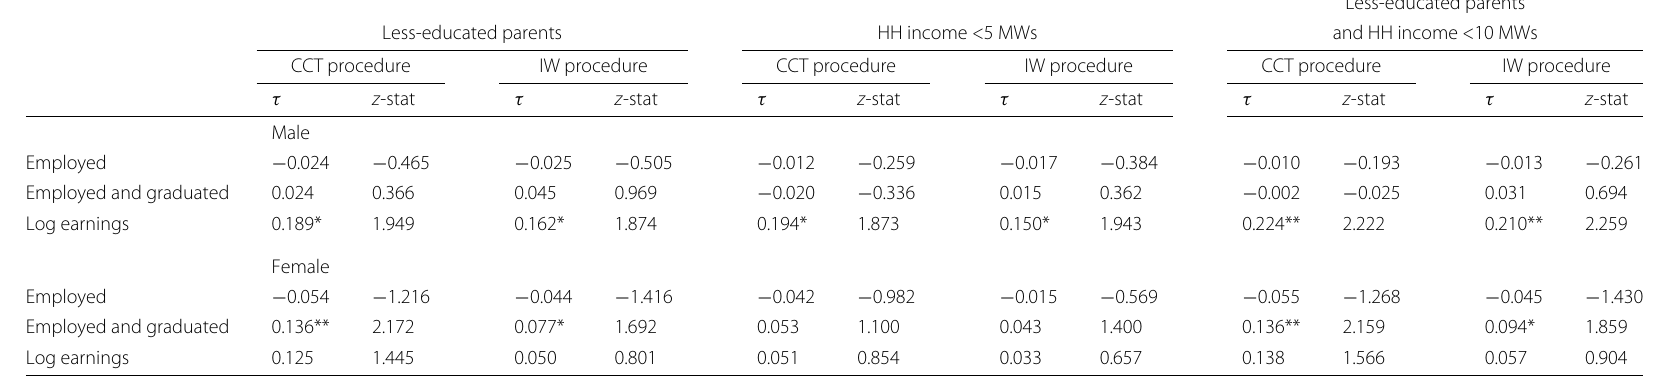
Table 8 RD estimates of employment and earnings at 25 years